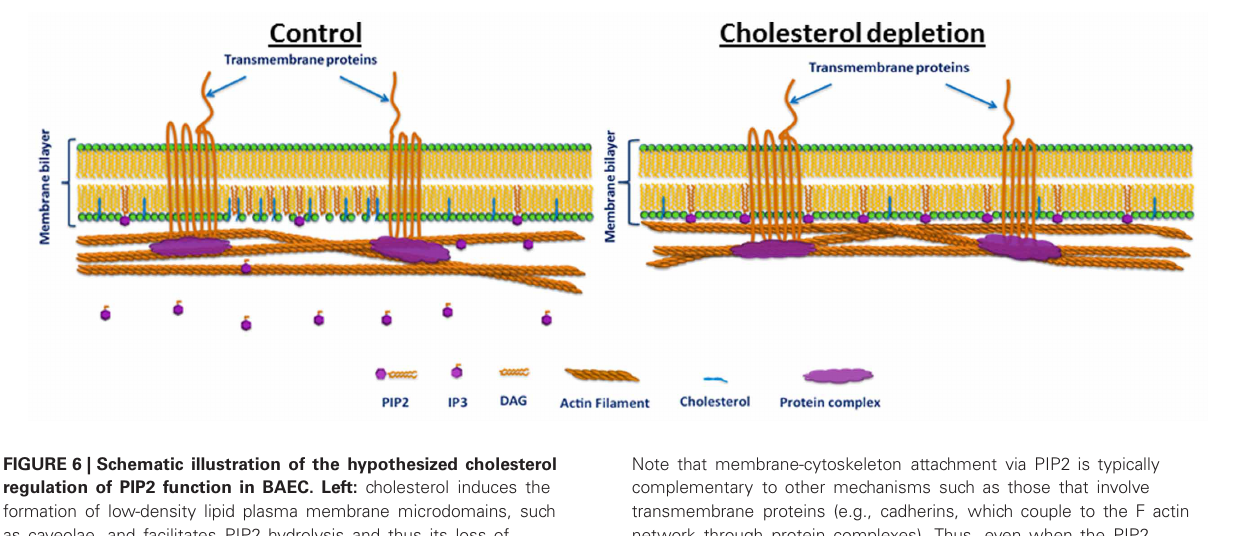
Note that membrane-cytoskeleton attachment via PIP2 is typically complementary to other mechanisms such as those that involve transmembrane proteins (e.g., cadherins, which couple to the F actin network through protein complexes). Thus, even when the PIP2 pathway is abrogated the membrane and the cytoskeleton may remain